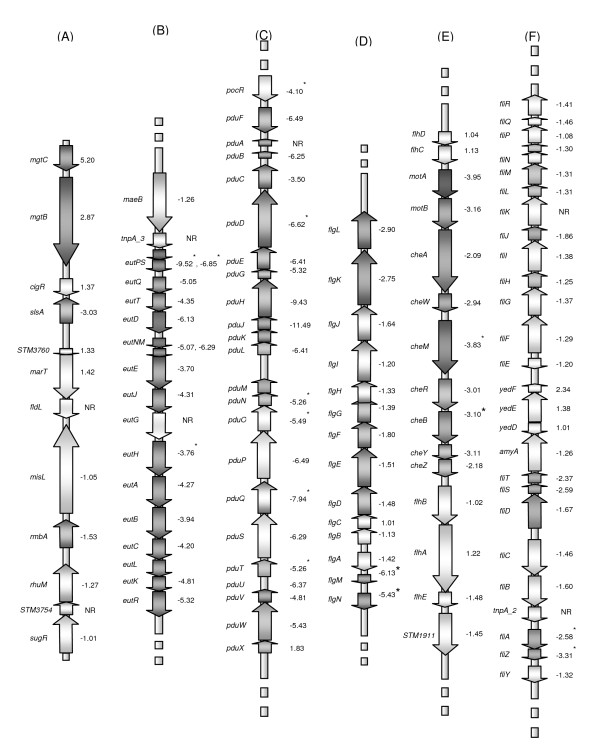
Organization of major genes for (A) SPI-3, (B) ethanolamine utilization, (C) propanediol utilization, and (D-F) flagellar biosynthesis and motility. The names of genes are listed to the left of the arrow, an (*) next to the gene indicates the presence of at least one ArcA motif in the 5' - region, the numbers listed to the right of the arrows indicates the ratio of gene expression in the arcA mutant relative to that in the WT, and the shading corresponds to the level of gene expression. NR = no expression ratio.